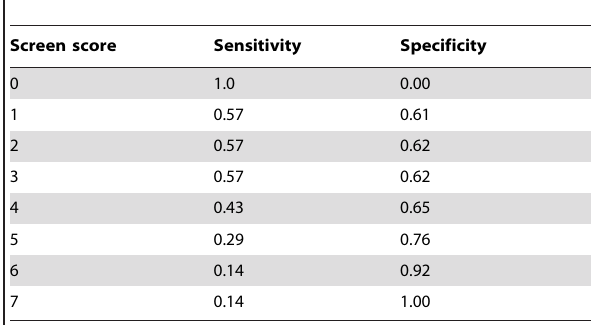
Table 6. Sensitivity and specificity of the screening